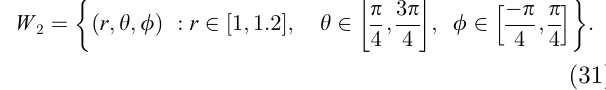
Figure 5. Boundary input v n on the actual source o D a .